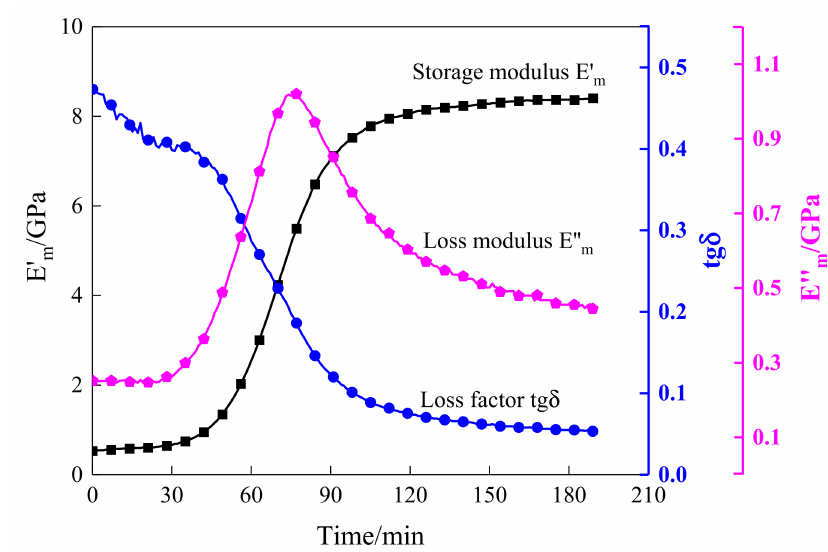
Figure 3. DMA testing curves of T300